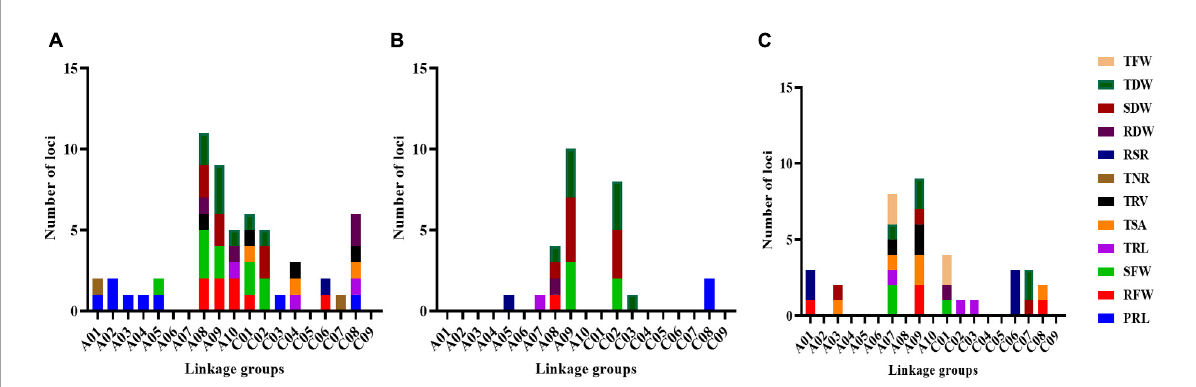
FIGURE3 Information of loci detected for RMT and BT under LN/LP/LK conditions. (A) Distribution of loci on 19 linkage groups for RMT and BT under LN-stress conditions. (B) Distribution of loci on 19 linkage groups for RMT and BT under LP-stress conditions. (C) Distribution of loci on 19 linkage groups for RMT and BT under LK-stress conditions. Different colors shows the investigated